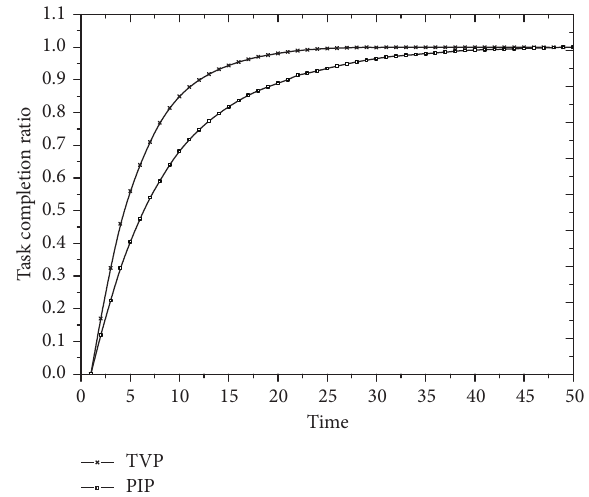
Figure 4: Task type where utility is directly proportional to task progress.